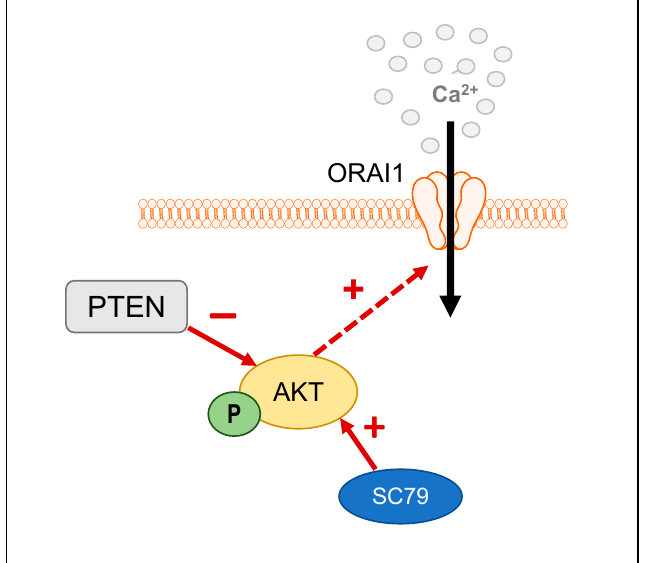
Figure 6. Graphical schematic summarizes the regulation of ORAI1-mediated Ca 2+ influx by AKT. Increased AKT phosphorylation as a result of either PTEN silencing or pharmacological activation with SC79, results in increased Ca 2+ influx through ORAI1 channels.